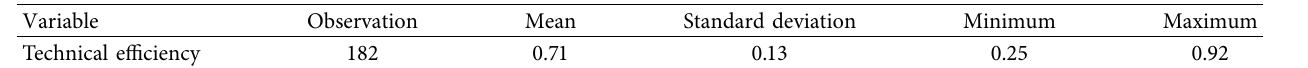
Table 4: Overall technical efficiency of maize seed production.